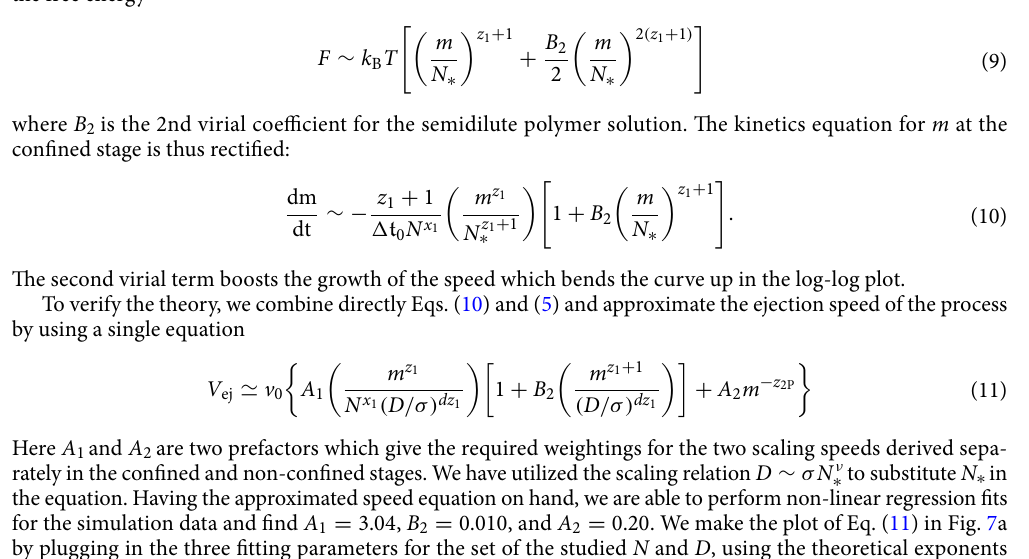
lines in the non-confined stage. Decreasing or increasing z 2P inclines the horizontal lines to the right (in Panel (a)) or to the left (in Panel (c)). V ej To understand the details of the speed scaling in the non-confined stage, we plot as a function of m for (cid:31) (cid:30) D in Fig. 6a. We can see that the ejection increases its speed with decreasing m and the speed curves fol- = ∞ low a universal path when m becomes small. According to the physical pictures described in "General ejection theory in a d -dimensional space" section, the process stays entirely in a non-confined situation. In the first half part of the process ( m > 0.5 N ), the free energy of the system goes uphill and the “ejection” is a Kramers escape m p < N problem. We have derived a formula for the escape time (refer to the case N in Table 1) and the − ∗ z 2E . In the second half part ejection speed in this part exhibits an overall scaling with the exponent equal to − of the process, the number m of the monomers in the cavity becomes smaller than the one s in the semi-space. At this moment, the ejection is driven by the entropic pulling of the chain segments from the outside. The free m − z 2P . Figure 6b shows energy goes downhill, and the ejection speed is described by Eq. (5) and scales as V ej ∼ V ej the variation of vs. m / N . By performing non-linear regression fits in the two regions, 0.01 < m / N < 0.5 (cid:31) (cid:30) 64 to 1024, we report the best estimates for and 0.5 < m / N < 0.95 , separately, for the chain lengths from N = 1.43 ( 3 ) and z 2E 1.18 ( 6 ) . To see the difference of the exponents, we have plotted the the two exponents: z 2P = = V ej m 1.43 versus m / N in Fig. 6c. The rescaled curves are horizontal in the region m / N < 0.5 rescaled speed � � × and turn to show m 0.25 scaling when m / N > 0.5 . Despite the fact that the ejection speed can be well described by the kinetics equation Eq. (5) in the non- confined stage, a large bending-up effect, away from the predicted scaling V ej